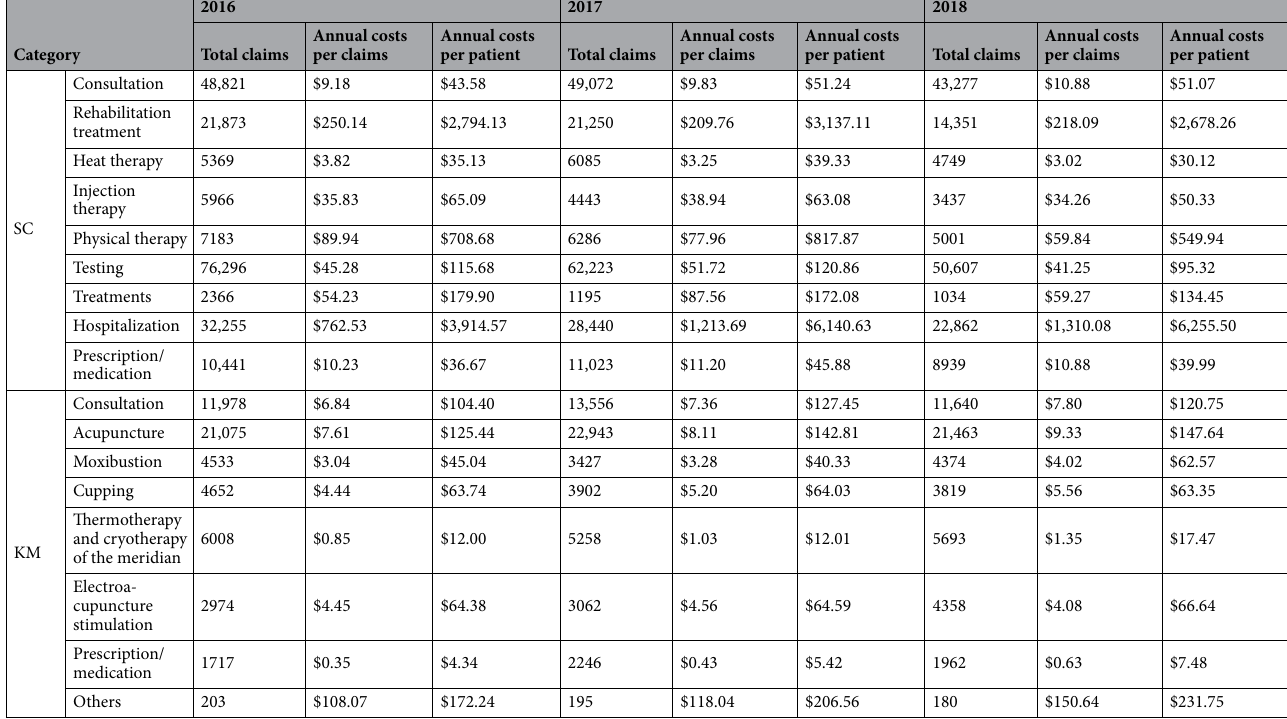
Table 2. Frequency of healthcare service codes for sequelae of cerebrovascular disease. SC standard care, KM Korean medicine. All costs were converted using the annual average exchange rate (KRW/USD) of the corresponding year. The price level of healthcare cost is adjusted for 2018 (see Supplementary Table